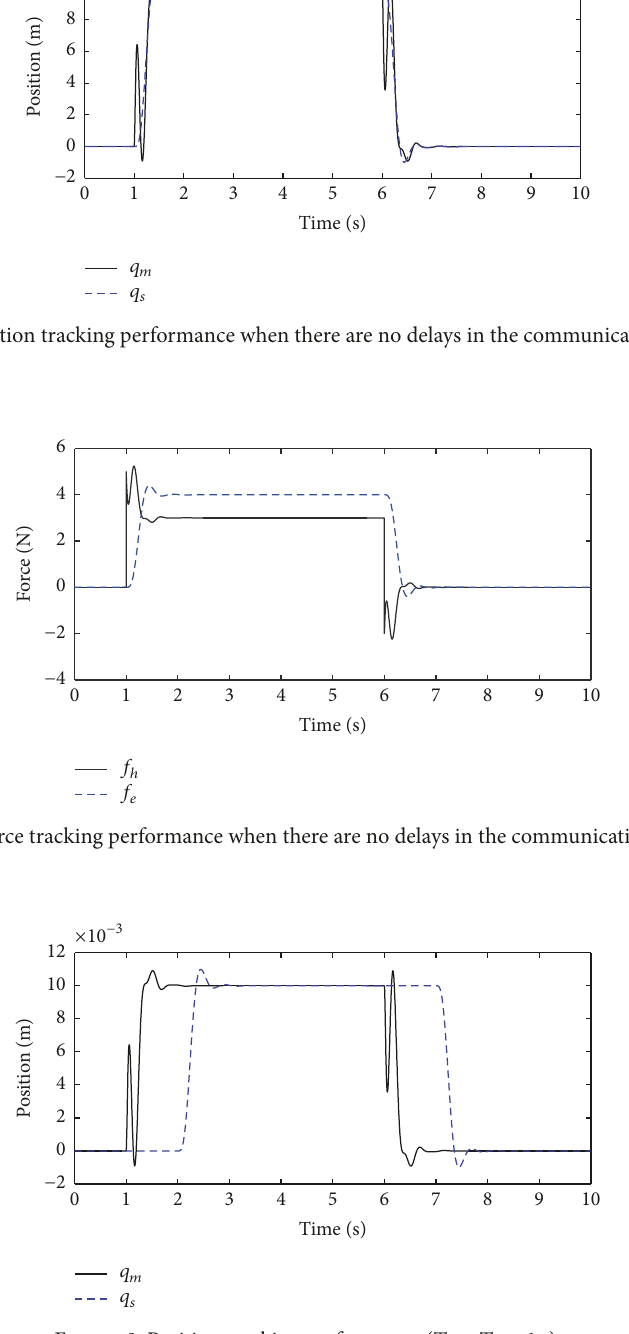
Figure 9: Position tracking performance ( 𝑇 1 = 𝑇 2 = 1